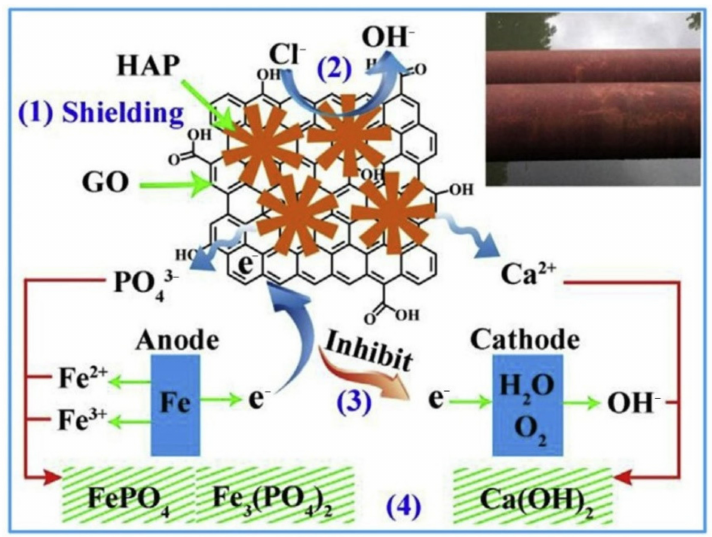
Figure 15. The anticorrosion mechanism of GO-HAP (Reproduced with permission from ref. [84]. Copyright 2019 Elsevier Publications).